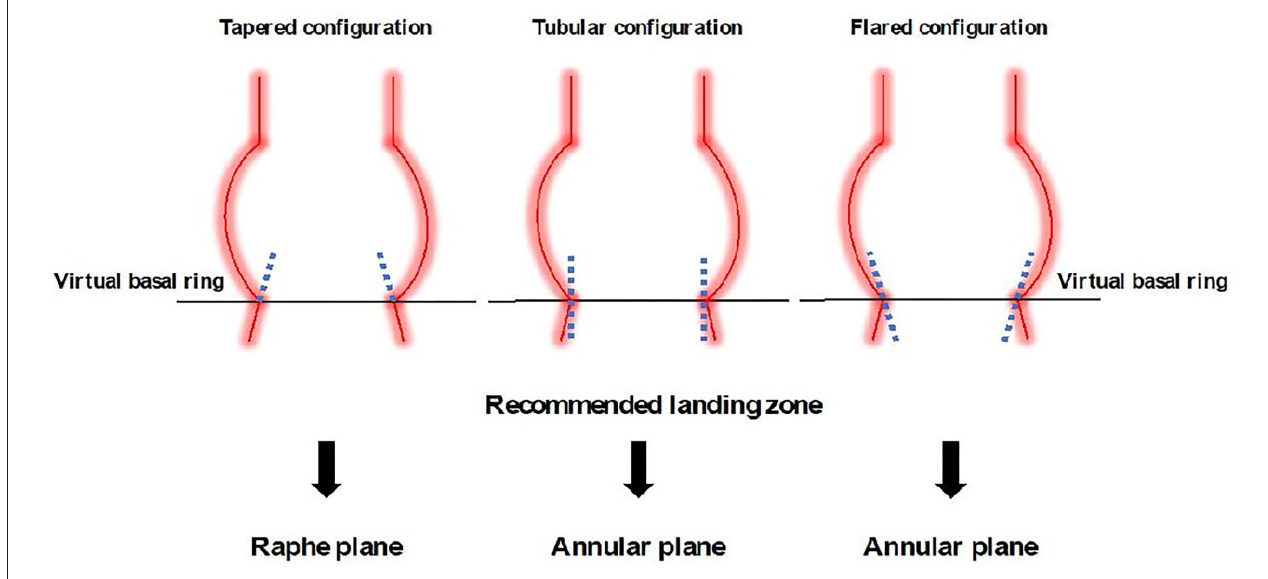
FIGURE 3 | Recommended prosthesis sizing according to the aortic root morphology in BAVs.